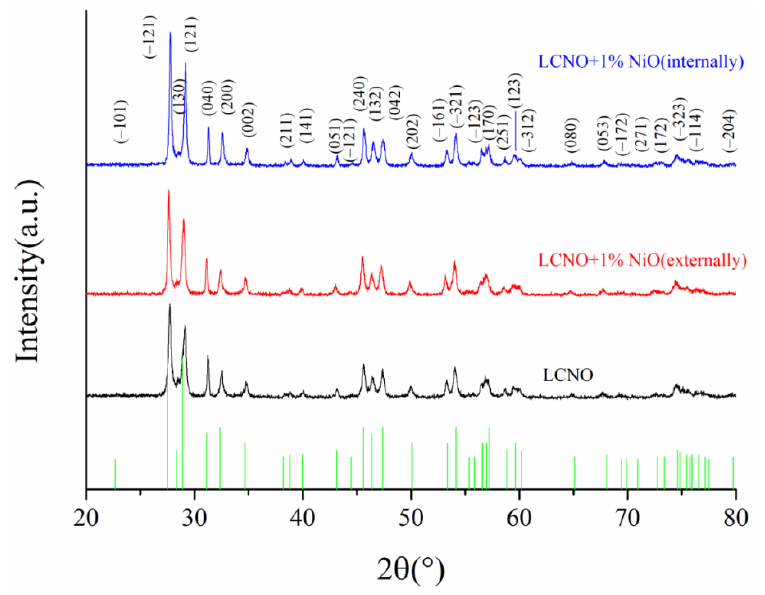
Figure 1. XRD patterns for LCNO powder and 1 wt.% NiO-doped LCNO powders (externally and internally) fired at 1100 °C.